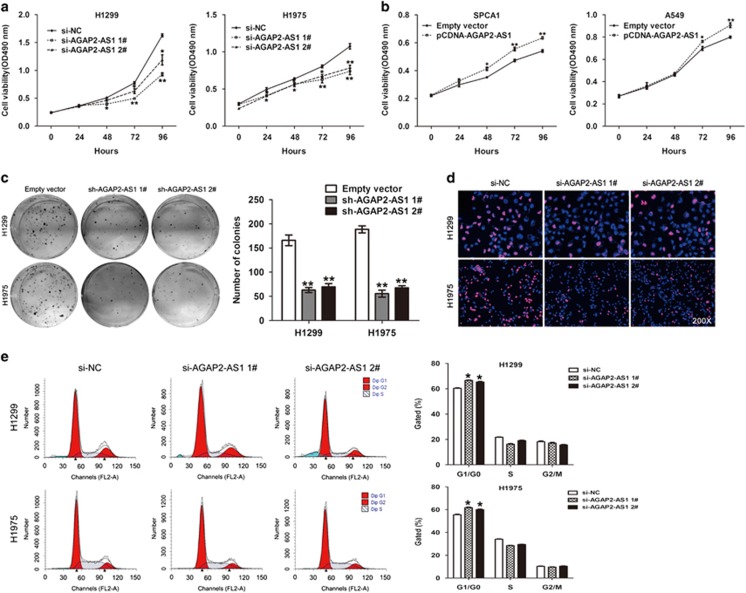
Effects of AGAP2-AS1 on NSCLC cell proliferation and cell cycle progression in vitro. (a and b) MTT assays were used to determine the cell viability for si-AGAP2-AS1-transfected H1299 and H1975 cells, or pCDNA-AGAP2-AS1-transfected A549 and SPCA1 cells. (c) Colony-forming assays were conducted to determine the cloning ability of sh-AGAP2-AS1-transfected H1299 and H1975 cells, and control cells. (d) EdU staining assays were conducted to determine the viability of si-AGAP2-AS1-transfected H1299 and H1975 cells. Red, EdU staining for dividing cell; blue, DAPI staining for nuclear. (e) Flow cytometry assays were performed to analyze the cell cycle progression when NSCLC cells transfected with si-AGAP2-AS1. The bar chart represented the percentage of cells in G0/G1, S or G2/M phase, as indicated. All experiments were performed in biological triplicates with three technical replicates and values represented the mean±S.E.M. *P<0.05, **P<0.01